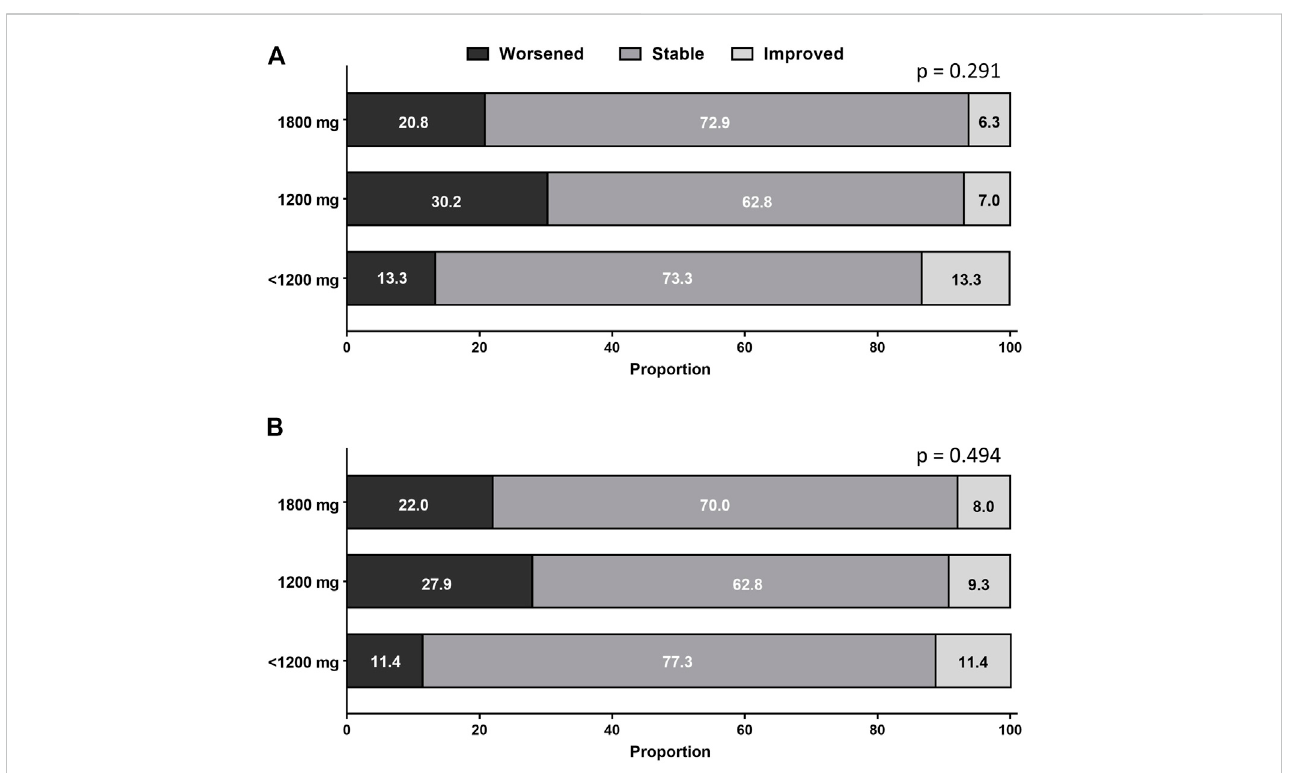
FIGURE 4 Categoricalchangesin (A) dyspneaand (B) coughaccordingtopirfenidonedose.Theproportionofpatientswhoexperiencedimprovement,nochange, or worsening in respiratory symptoms did not signi fi cantly differ between the